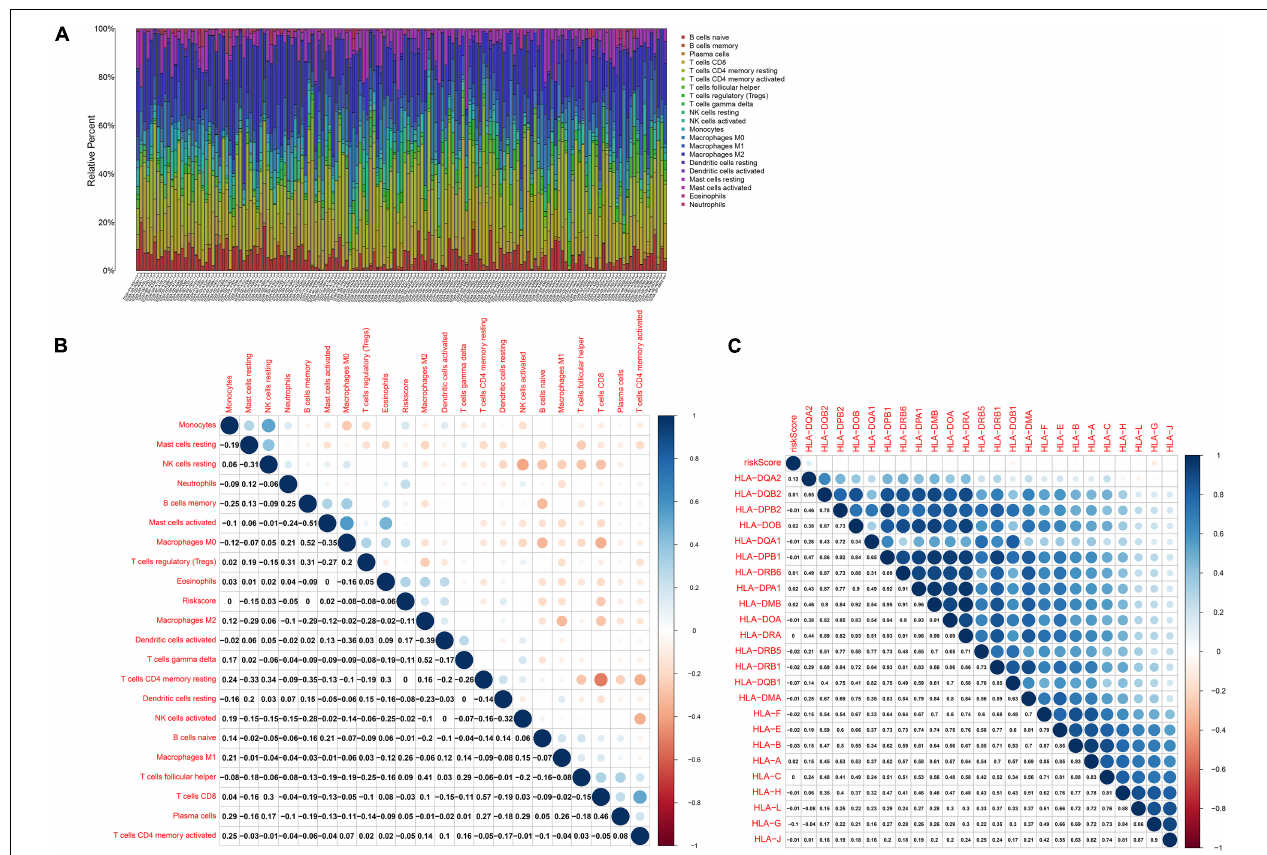
FIGURE 7 | The risk score is related to the immune microenvironment of HBV-related HCC in the TCGA dataset by CIBERSORT. (A) The proportions of immune cells in HBV-related HCC samples. (B) Heatmap of the correlations between the risk score and immune cells. (C) Heatmap visualizing the correlations between the risk score and HLA expression. Correlation coefficients were marked in the